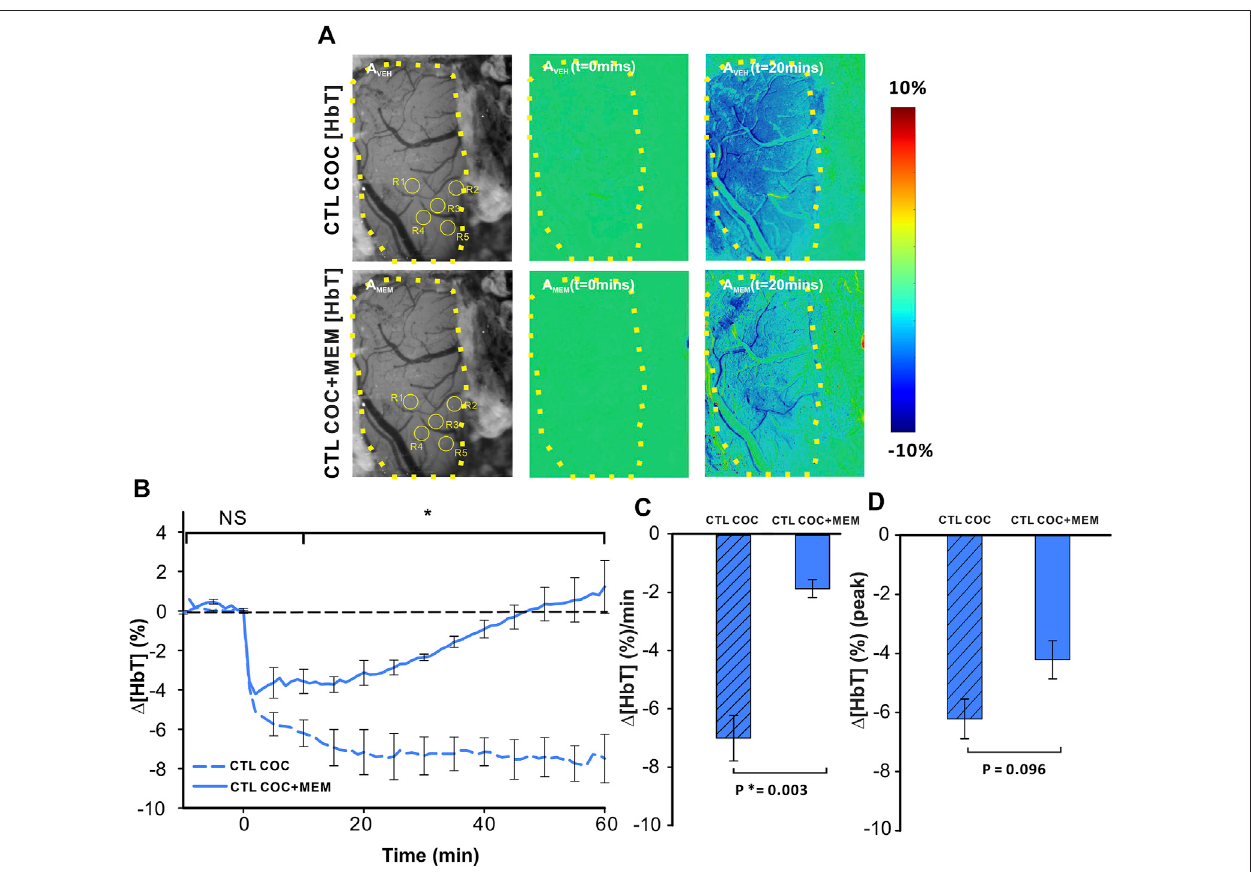
FIGURE 4 | Memantine attenuates cocaine-induced Δ [HbT] decrease in the PFC of control animals. (A) Ratio imaging demonstrating the spatiotemporal cocaine- induced reduction in total hemoglobin ( Δ [HbT]) in the rat PFC with vehicle (upper panels) and memantine (lower panels) pretreatments. The area encompassed by dashed yellow lines represents the region of brain visualized with the yellow circles indicting the location of ROI for quanti fi cation in A VEH and A MEM. (B) Exposure to memantine prior to cocaine improved cocaine-induced Δ [HbT] reduction as well as shortened the duration of Δ [HbT] response to cocaine. (C) Pretreatment